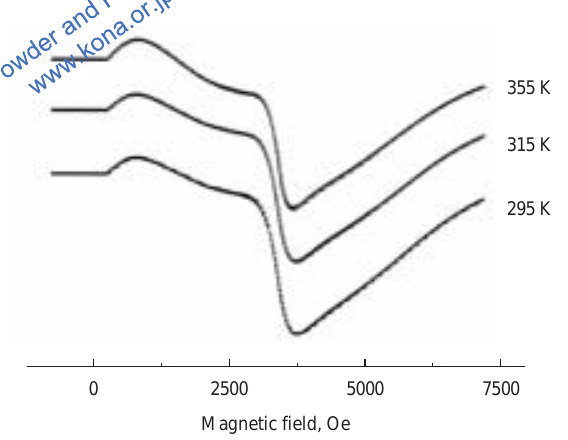
nanogranules.Magnetic Fig. 9 Microwave absorption hysteresis for Fe-containing sam- ples at room temperature. The arrows indicate the field- sweep Fig. 10 TEM microphotograph of the sample containing CdS nanoparticles on the surface of PTFE